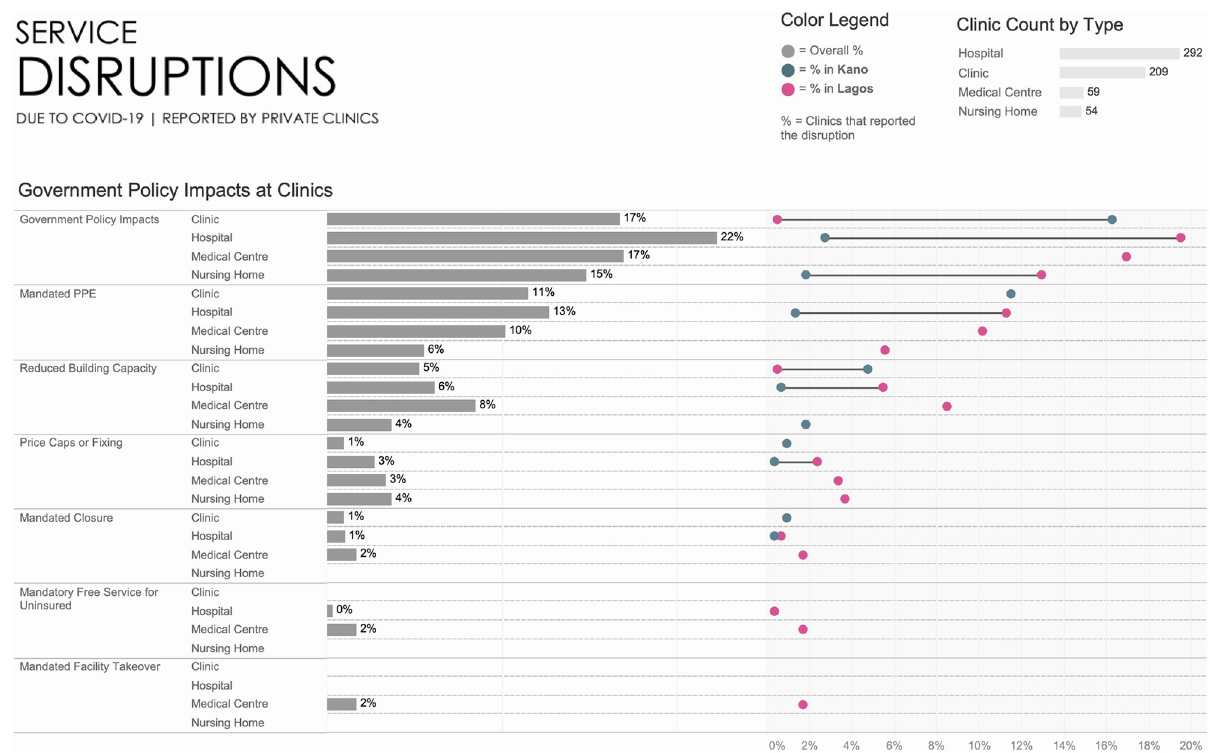
Fig 6. Service disruptions due to